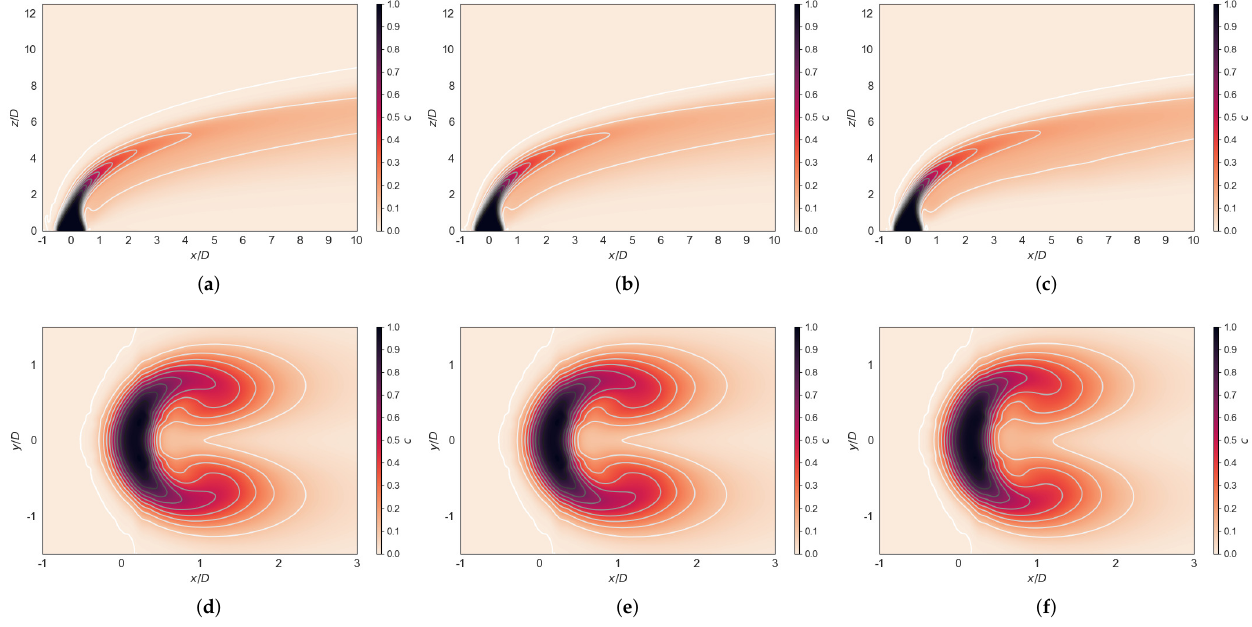
Figure 5. Two–dimensional plots of the scalar c at y / D = 0 (top) and z / D = 1.5 (bottom). ( a , d ) steady simulation using the k − ω TNT model; ( b , e ) transient simulation using the k − ω TNT model; ( c , f ) transient simulation using the k − ω SST